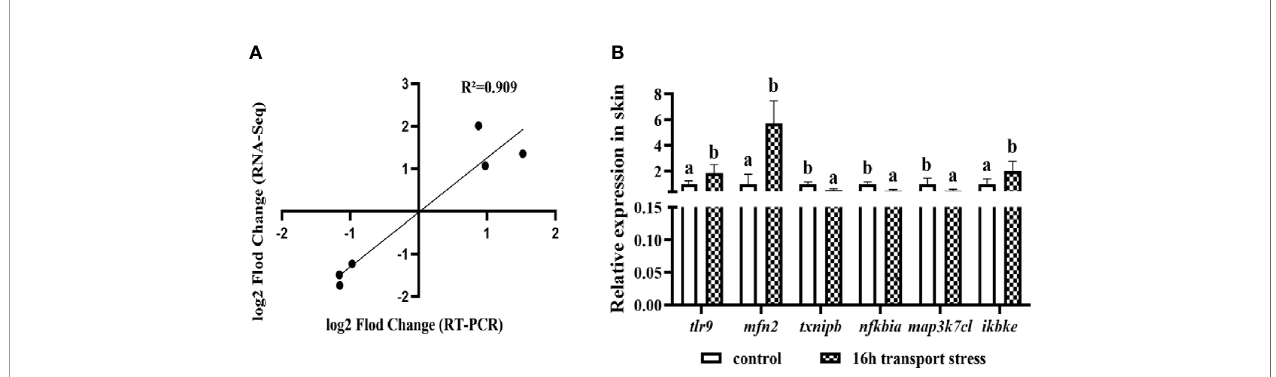
FIGURE 9 | Correlation between transcriptome results and RT-PCR results (A) ; Validation of tlr9 , mfn2 , txnipb , nfkbia , map3k7cl and ikbke gene transcript levels in skin by qRT-PCR (B) . Values are mean ± SD ( n =9). Different lowercase letters indicate signi fi cant differences ( P